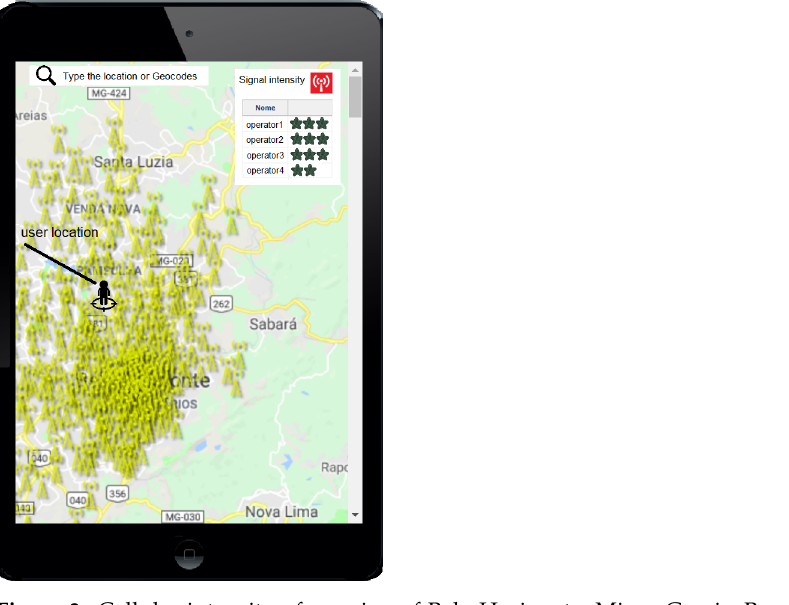
Figure 3. Cellular intensity of a region of Belo Horizonte, Minas Gerais, Brazil according to the Q-meter